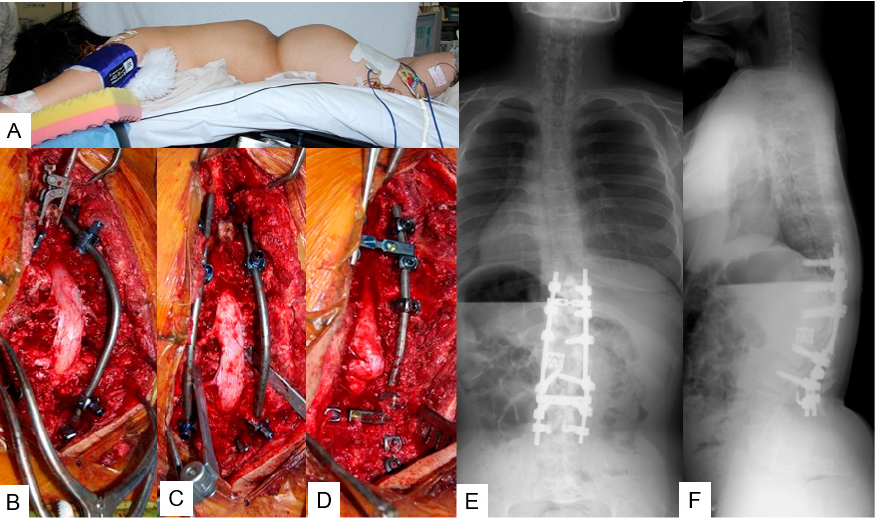
Figure 4. A 16-year-old girl with achondroplasia; intra- and postoperative radiograms. ( A ) Flexible surgical table; ( B – D ) intraoperative images; ( E , F ) postoperative radiograms.